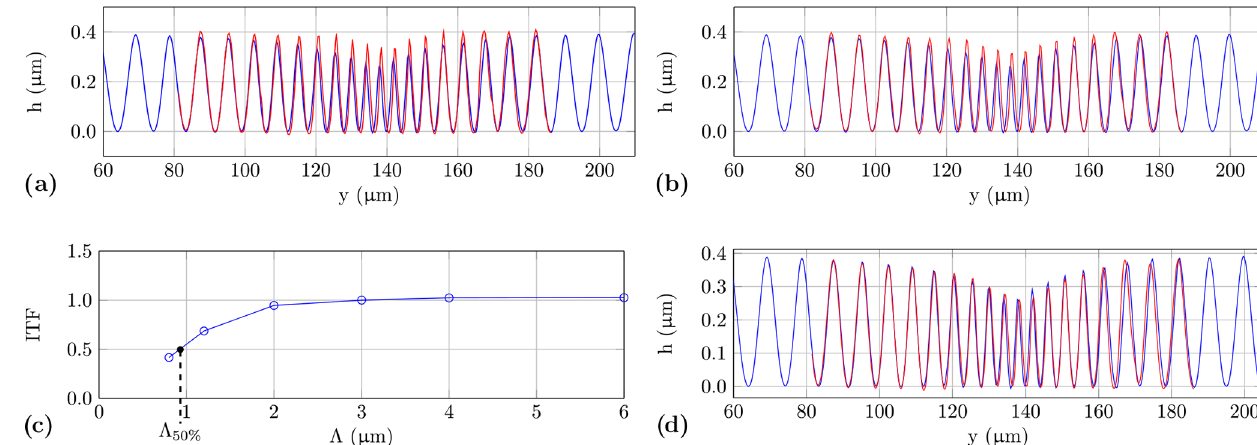
Figure 9. Transfer characteristics of the confocal microscope: (a) comparison of the chirp profile measured by confocal microscope (blue curve) and filtered profile according to Eq. (6) with an additional discretization by the camera pixels (red curve), (b) comparison of the measured profile of the confocal microscope (blue curve) to a reconstructed profile (red curve), (c) ITF resulting from the measured height of rectangular gratings with various spatial wavelengths in relation to the results of the AFM (see Table 2) with the spatial wavelength (cid:51) 50% equal to twice the spatial wavelength (cid:51) R according to the Rayleigh criterion, and (d) comparison of the profile obtained with the confocal microscope (blue) and a filtered profile (red) according to Eq. (4) with a filter width of 3 (cid:51) R .